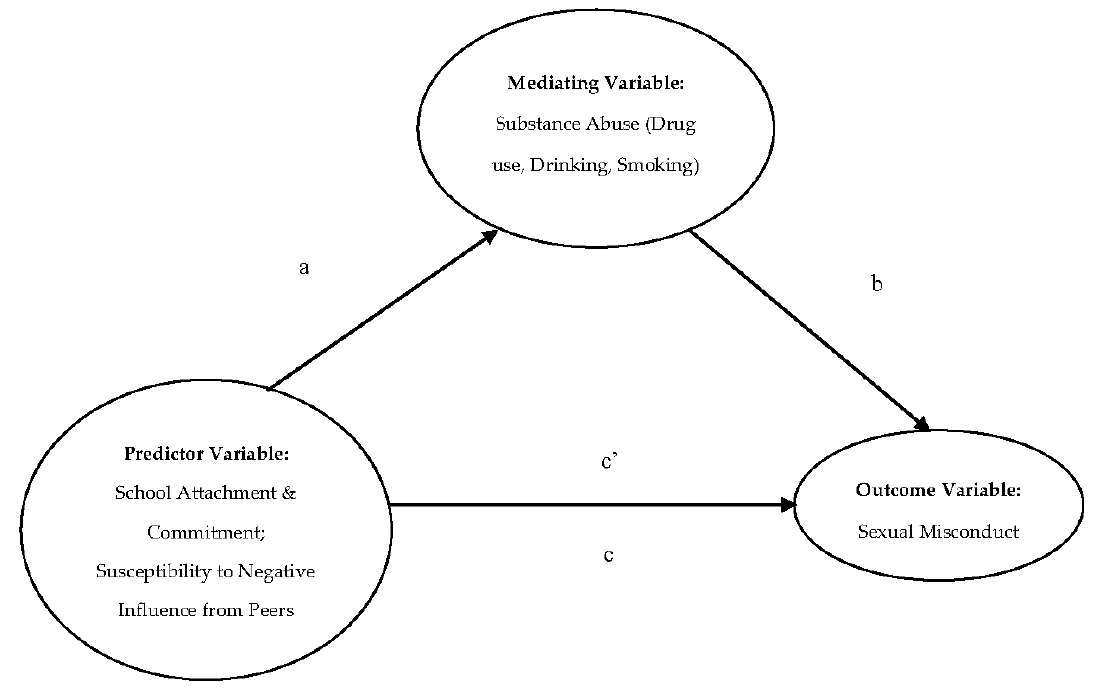
Figure 1. Conceptual model of the mediating regression analysis.